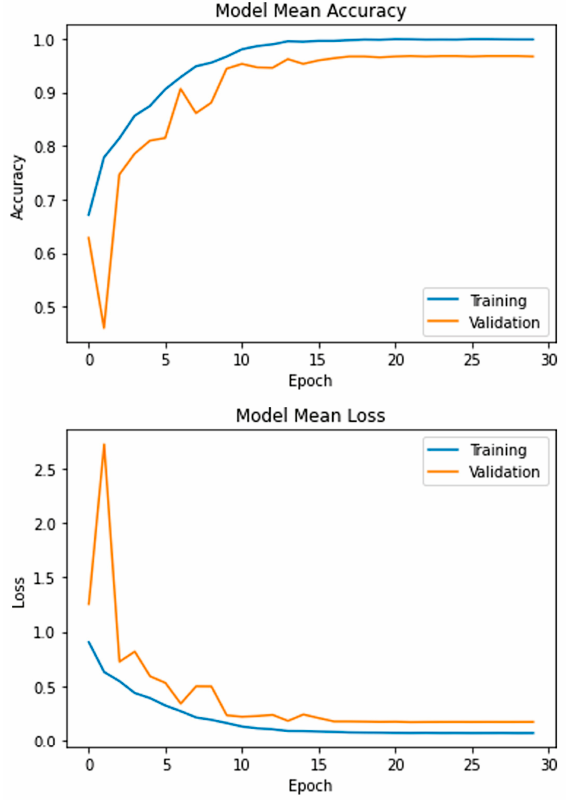
Figure 5. Mean accuracy and losses of the presented model .